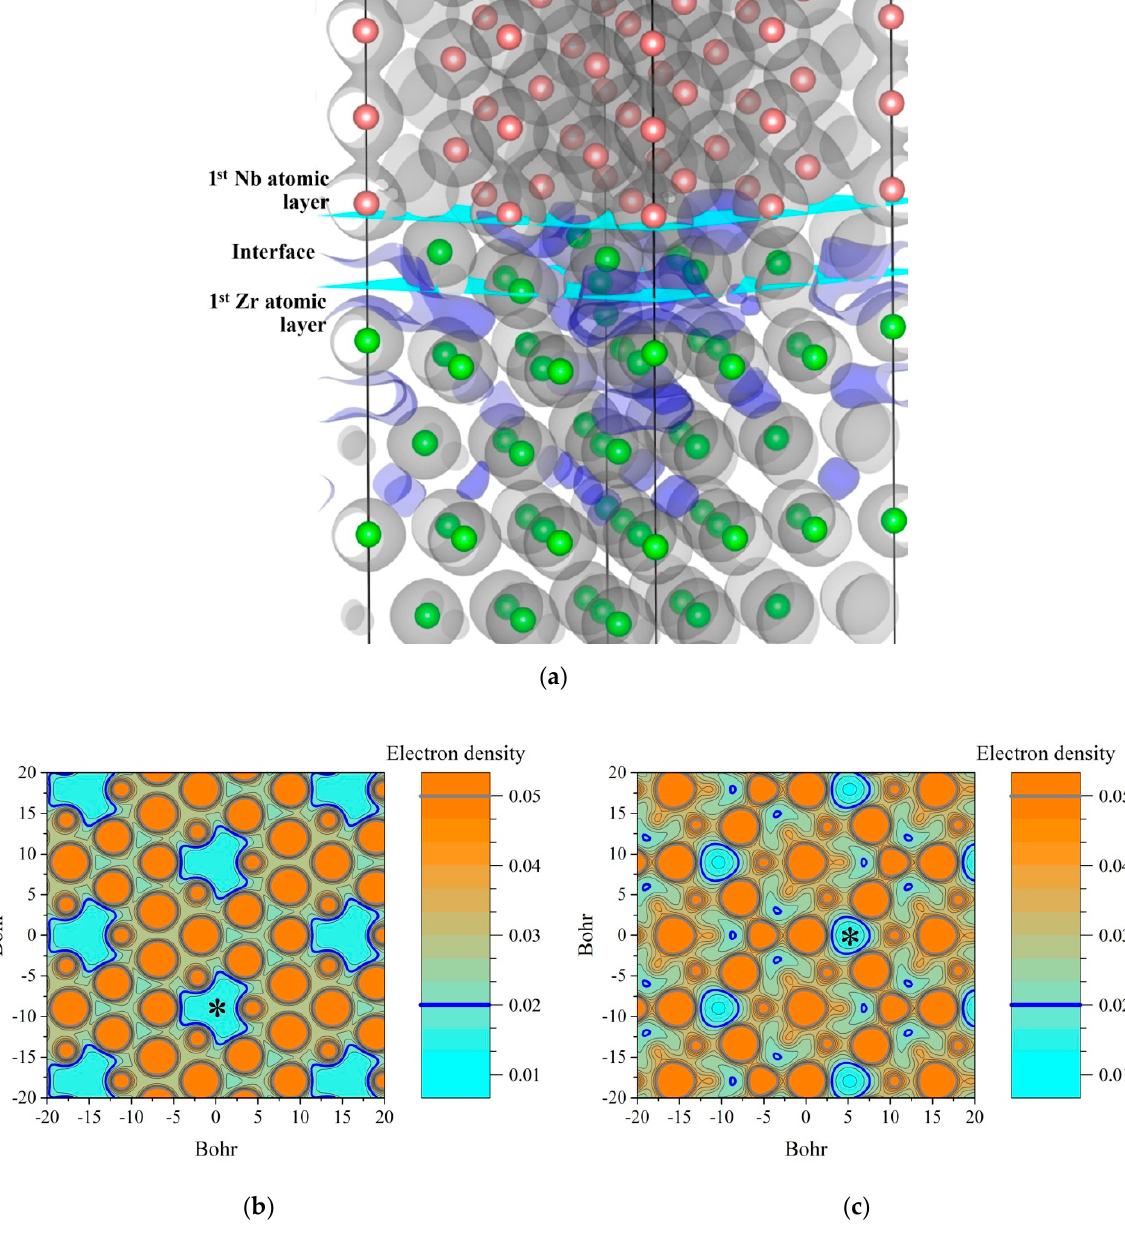
12 of 18 Figure 10. Dependence of S = f(W) for irradiated and as-deposited Zr/Nb 100. The dashed line in- dicates the approximating curve S = 0.744–1.185 W. The number of positron annihilation in Zr may be higher due to the selective posi- tron trapping [52] in the multilayer system caused by the positron affinity of zirconium which is 26% bigger than for niobium [53]. However, suppose the thickness of individual layers is about 100 ± 20 nm, and the average positron diffusion length is comparable with nanocrystallites’ size-32 ± 15 nm. In that case, it is unlikely that all positrons annihilate only in Zr. Therefore, the obtained value of 0.525 ± 0.005 should be assigned to the mixed